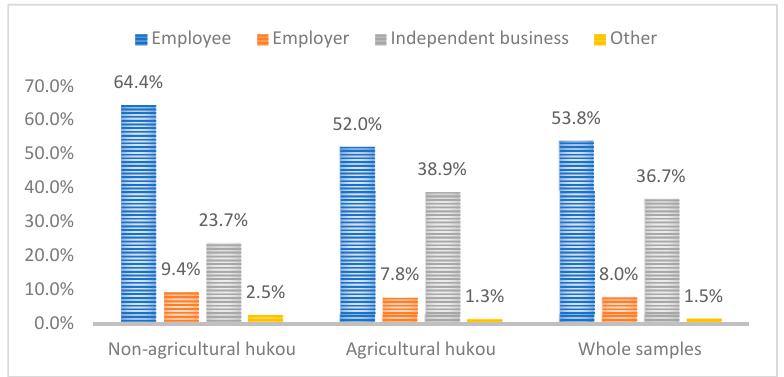
Figure 2. Employment status of various samples.